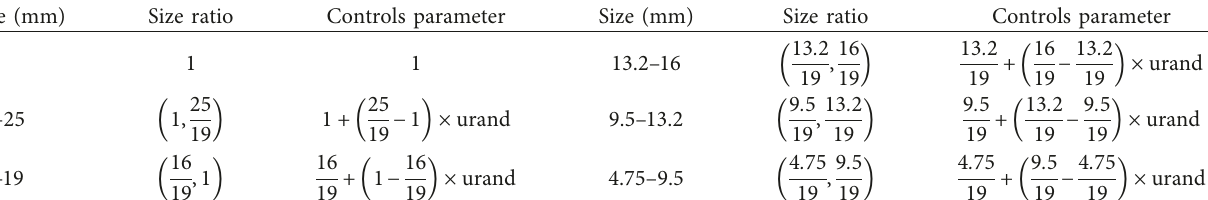
Table 1: Size adjustments for